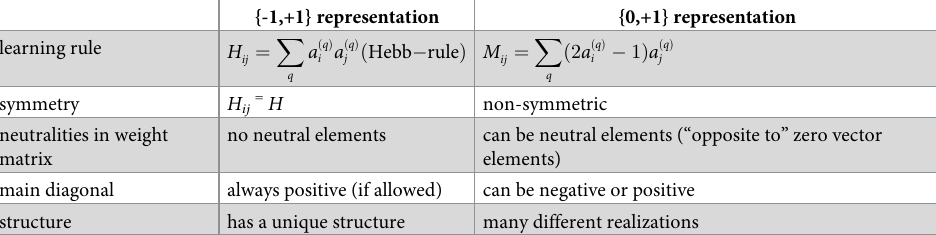
Table 1. Comparison of the resulting analytic interaction matrices for an autoassociative task with the two representations. {-1,+1}